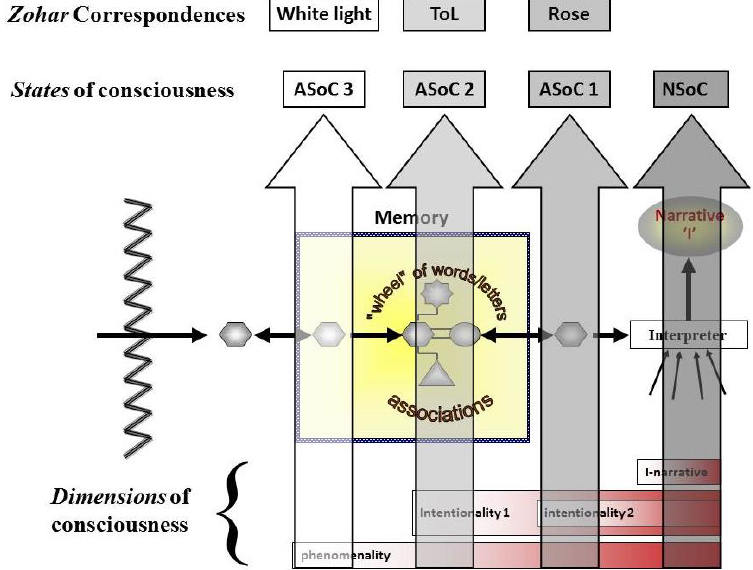
Figure 3. States of